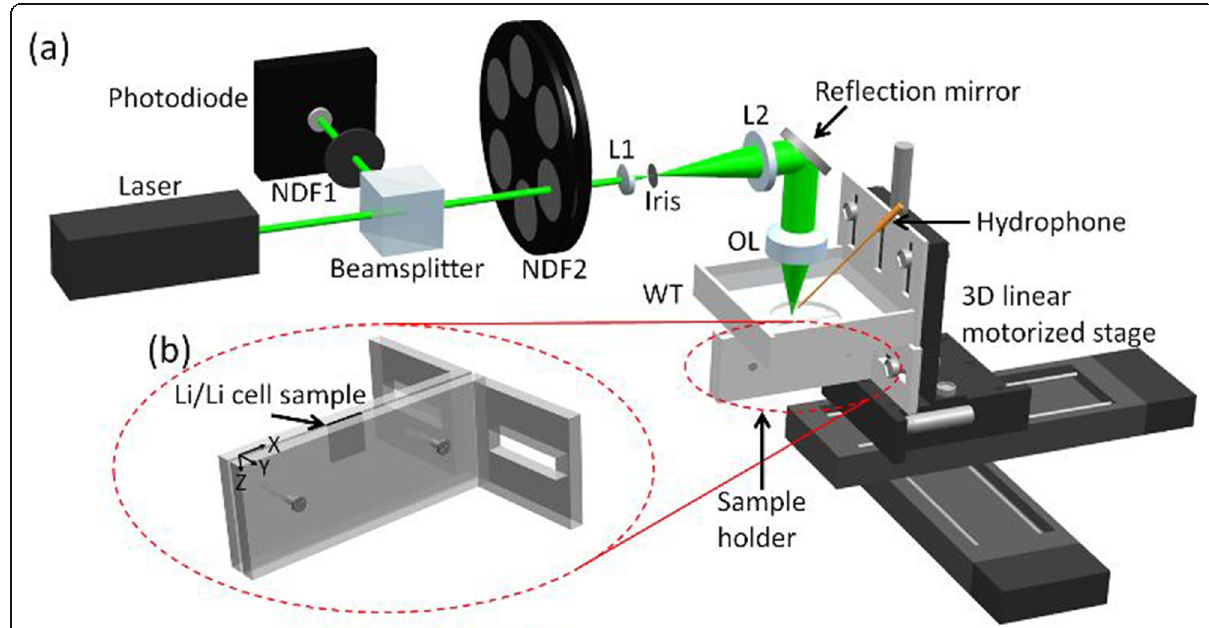
Fig. 2 Typical PA imaging setup for NDT/E [11]. ( a ): Schematic of OR-PAM imaging setup; ( b ): Custom-made sample holder. NDF1: neutral density filter 1; NDF2: neutral density filter 2; L1: lens 1; L2: lens 2; OL: objective lens; WT: water